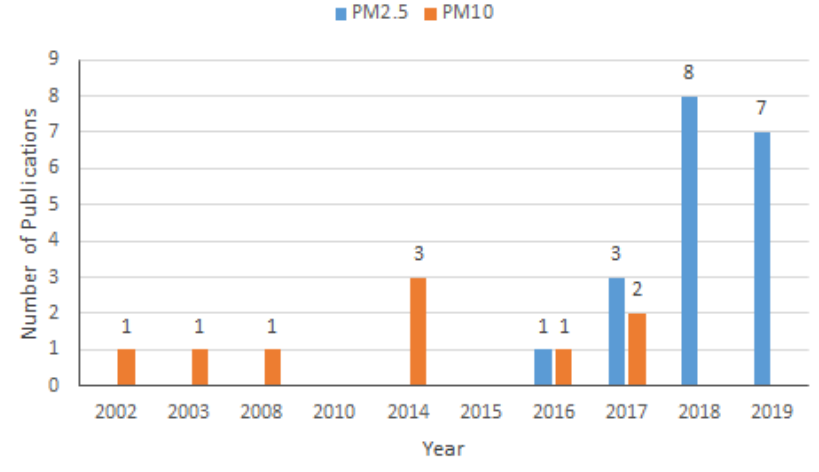
Figure 8. Number of the publications focused on the prediction of PM 2.5 and PM 10 over the years.